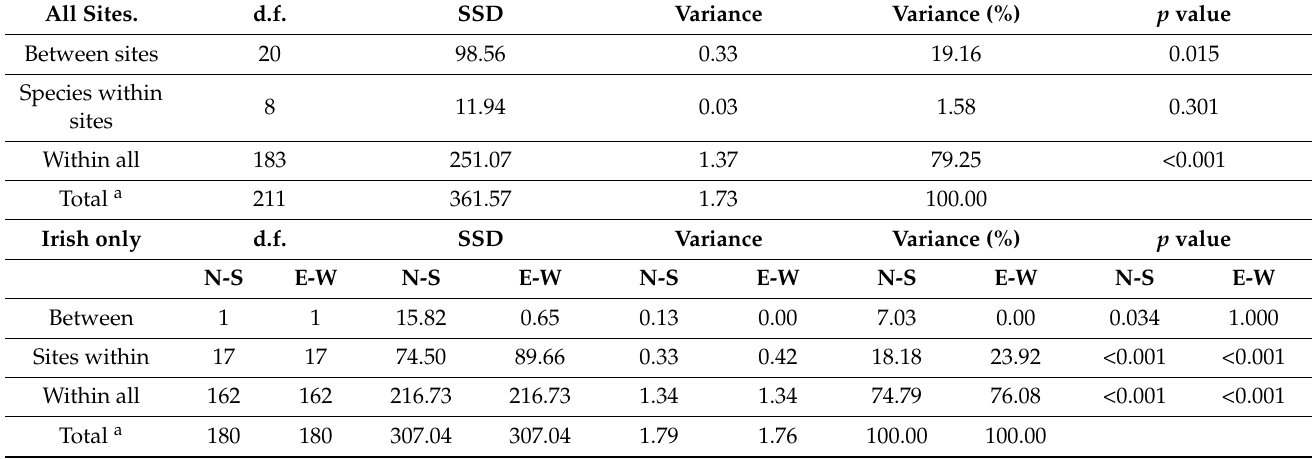
Table 5. ( Top ) Results of a nested AMOVA between species nested within all populations (sites occurring in Ireland and England). ( Bottom ) Nested AMOVA between Irish populations nested within either a north or south (N-S) location, or an east or west (E-W) location. p values were computed across 1000 permutations of the data. All